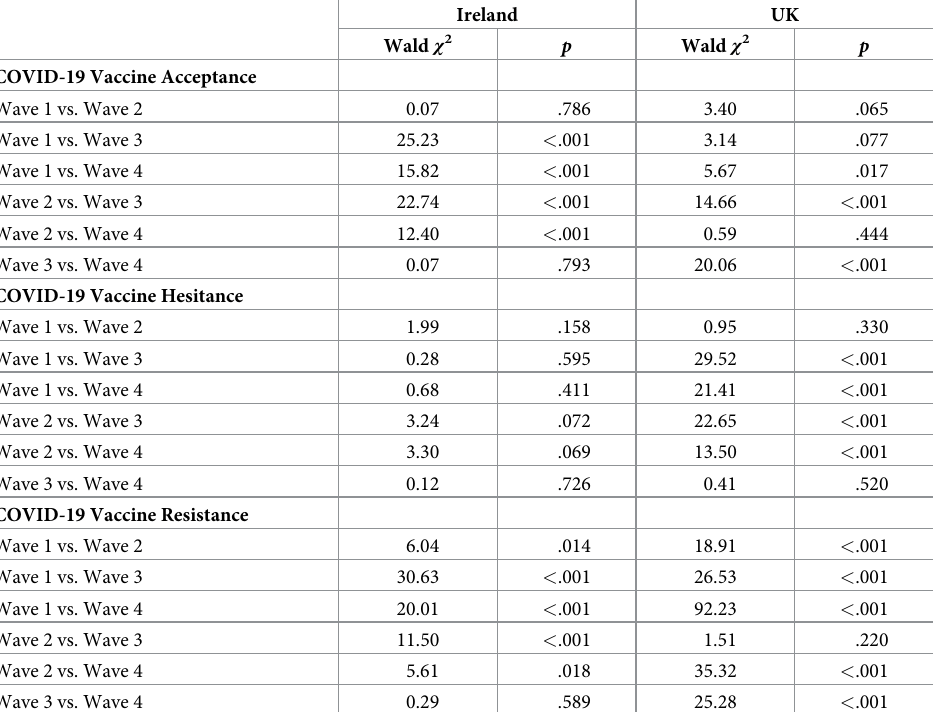
Table 2. Pairwise comparisons for the Irish (N = 1,030) and UK (N = 2,020) samples. Ireland UK